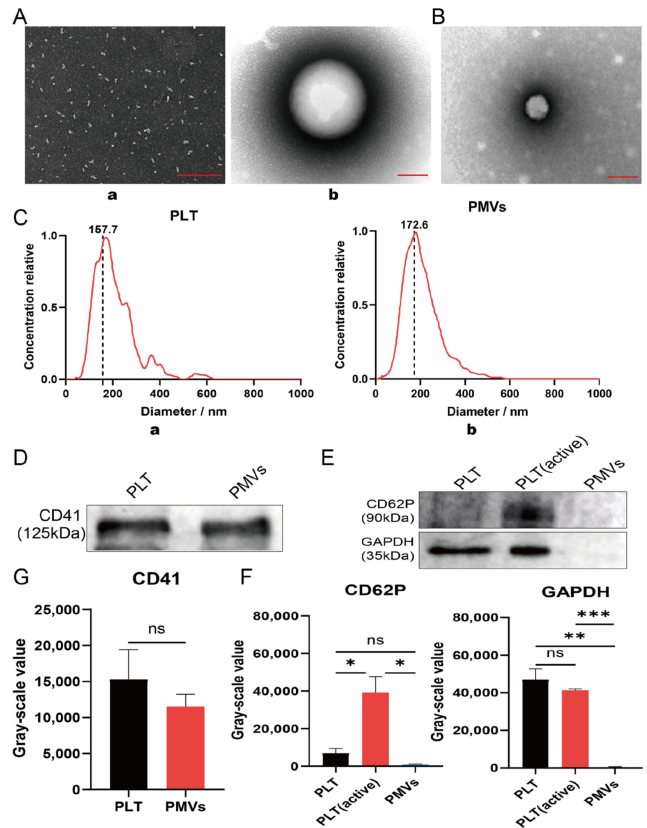
Figure 2. Characterization of PLT and PMVs in vitro. ( A ) SEM image of PLT. a —Scale bar, 1.0 µ m; b —Scale bar, 100 nm. ( B ) A transmission electron micrograph of platelet membrane vesicles (PMVs). Scale bar, 100 nm. ( C ) a , b —Size distribution of PLT and PMVs by nanoparticle tracking analysis. ( D ) Western blot analysis revealed the expression of platelet-specific markers including CD41 in platelets, PMVs. ( E ) Quantitative analysis of the membrane protein CD41. ( F ) CD62P and GAPDH expression levels of PLT, PLT (active), and PMVs (PLTs were activated with 1% CaCl 2 for 2 h). ( G ) Quantitative analysis of CD62P and GAPDH. * p < 0.05; ** p < 0.01; *** p < 0.001; ns >